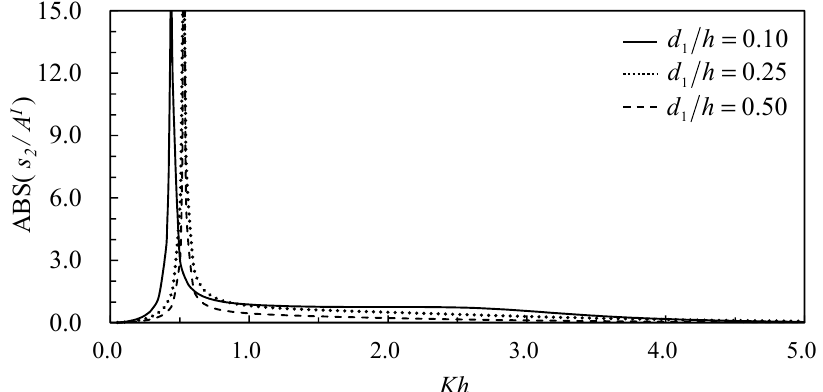
Figure 15. Dimensionless surge amplitude versus relative water depth for various submerged depths of the structure ( d 1 / h = 0.10, 0.25, and 0.50).